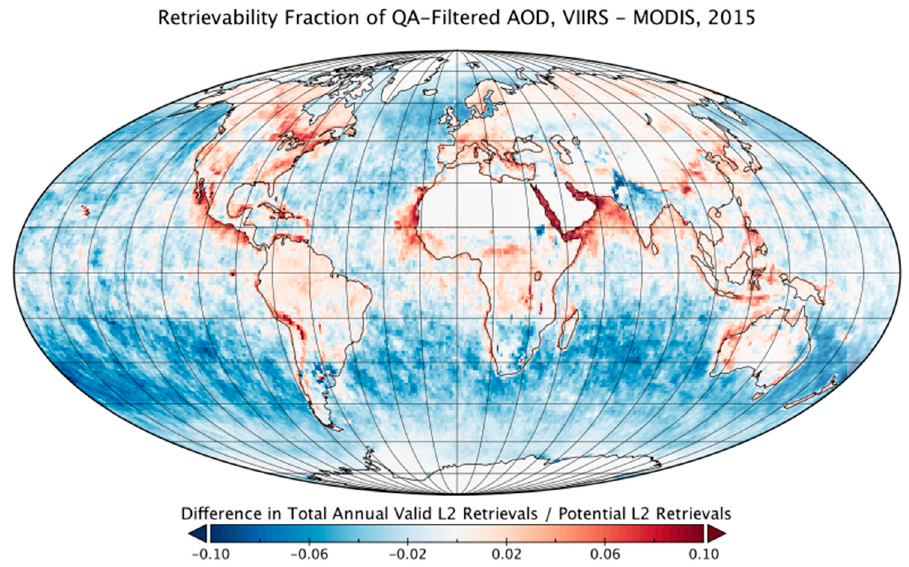
Figure 19. Di ff erence in retrievability fraction during 2015 for QA-filtered AOD, VIIRS SNPP Figure 19. Difference in retrievability fraction during 2015 for QA-filtered AOD, VIIRS SNPP v1.1– v1.1–MODIS Aqua C6.1. The global mean di ff erence is − MODIS Aqua C6.1. The global mean difference is − 0.02.